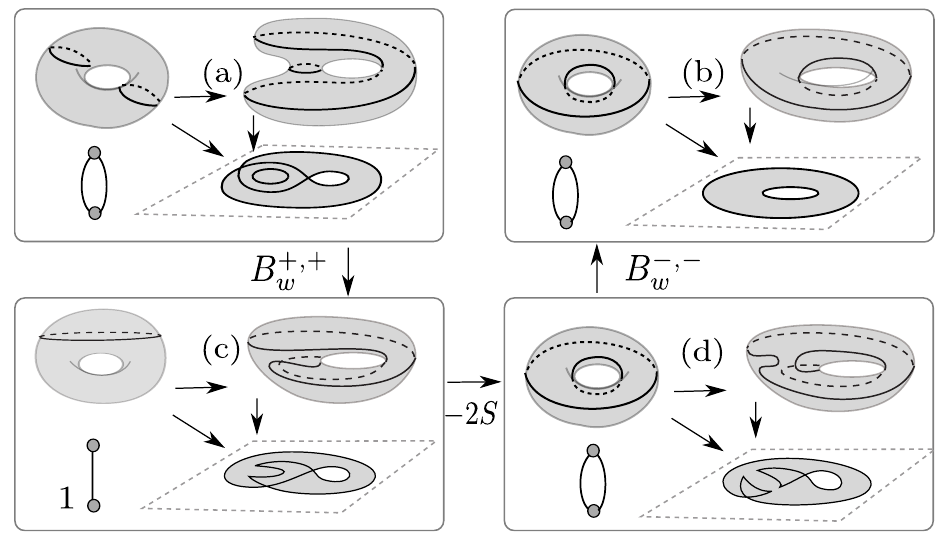
Figure 10. Examples of transitions B + , + w and B − , − w